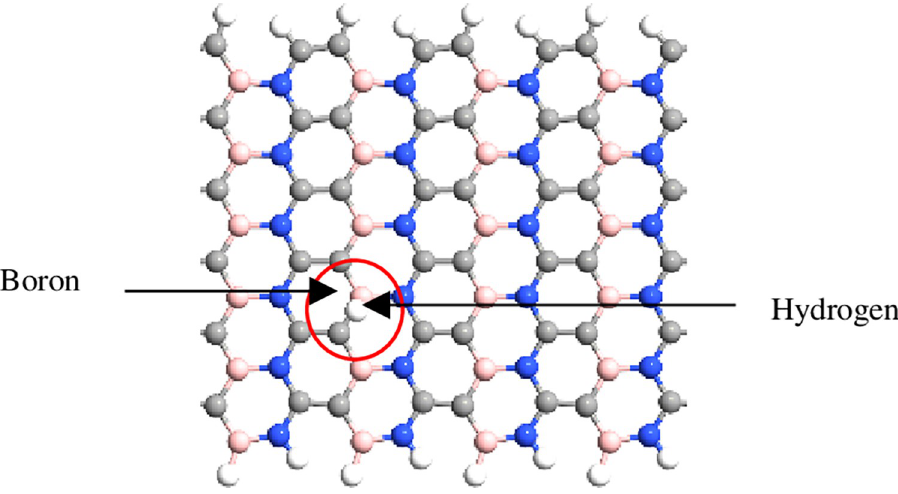
Fig 3. Optimized structures of 12-BC 2 NNR with different positions of H 2 gas molecules at boron atom.